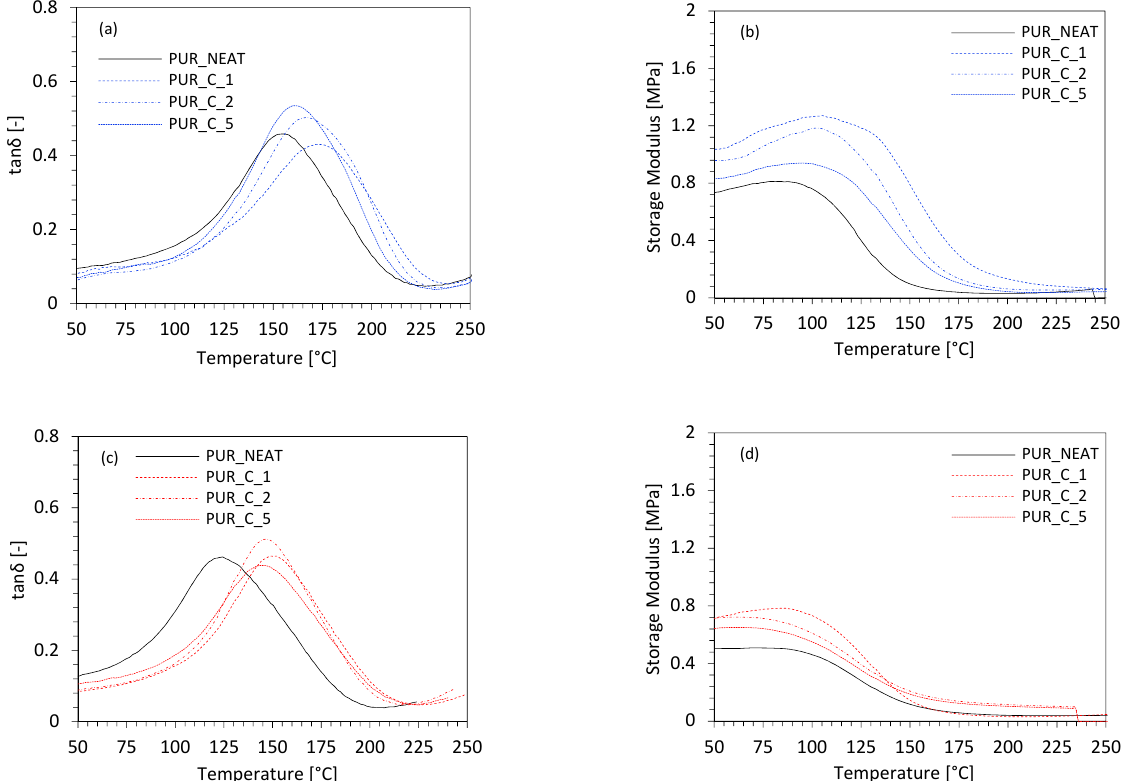
Figure 12. Dynamic-mechanical properties of PUR composites measured ( a , b ) before, and ( c , d ) after the UV-aging. Thermal decomposition of the PUR composites was evaluated using thermogravi- metric analysis (TGA) and derivative thermogravimetric analysis (DTGA). The results are shown in Table 4 and Figure 13. Table 4. The results of the thermogravimetric and derivative thermogravimetric analyses.